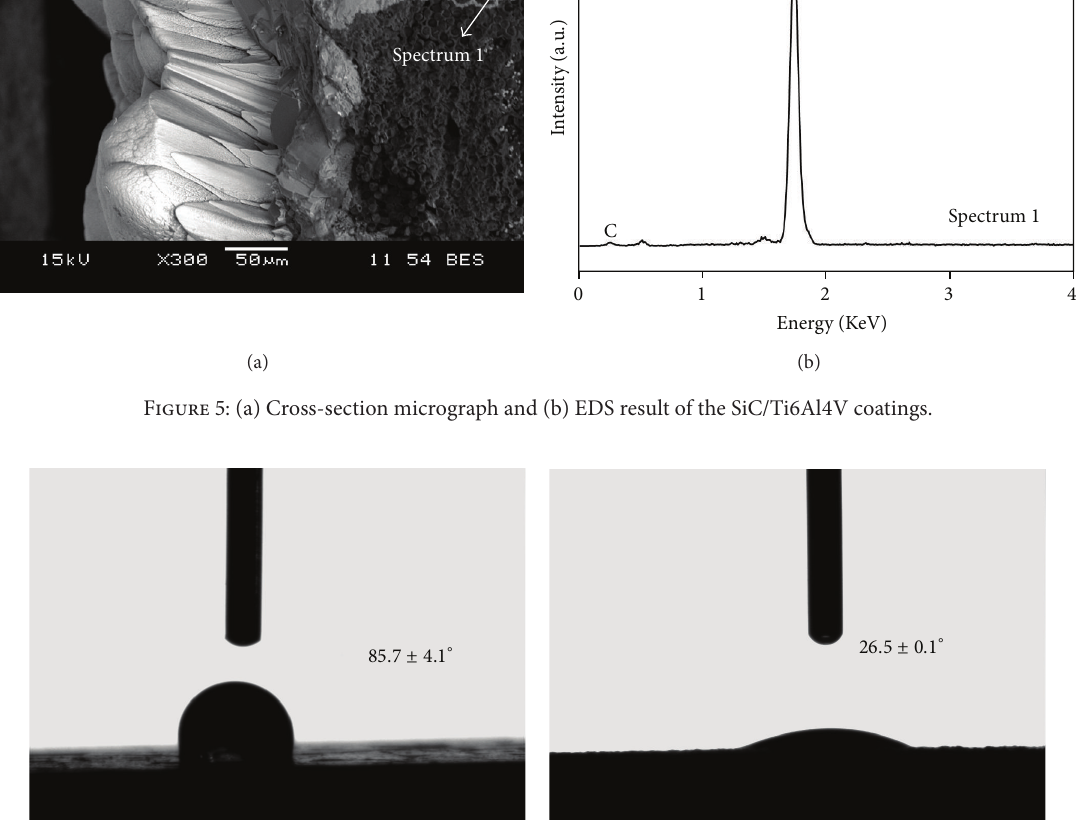
SiC interlayer coated C/C composites. The deposition of the Ti6Al4V coatings is primarily following the contours of the SiC